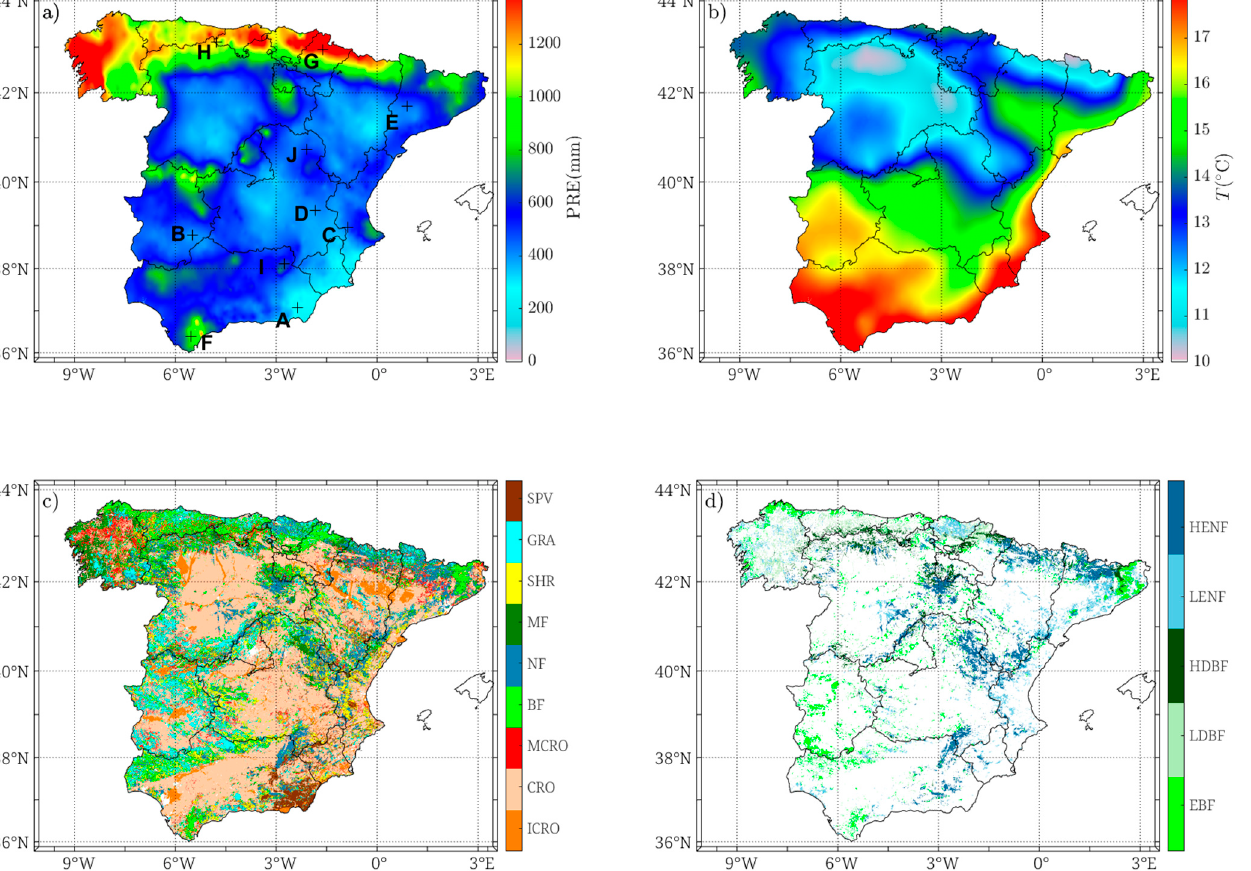
Figure 1. Spatial distribution of the average annual precipitation ( a ) and the average annual T ( b ) for the 2004–2018 period. Black crosses refer to the location of the sites used for the local analysis (A–J). ( c ) Vegetation type map [25] used in the estimation of the GPP: GRA (grasslands), SHR (shrublands), CRO (rainfed croplands), ICRO (irrigated crops), MCRO (mosaic cropland), BF (broadleaved forest), NF (needle-leaved forest), MF (mixed forest), SPV (sparse vegetation). ( d ) Specific forest type map used to derive the NPP: EBF (evergreen broadleaved forest), LDBF (low-altitude deciduous broadleaved forest), HDBF (high-altitude deciduous broadleaved forest), LENF (low-altitude evergreen needle-leaved forest), and HENF (high-altitude evergreen needle-leaved forest). These data are described in Section 2.